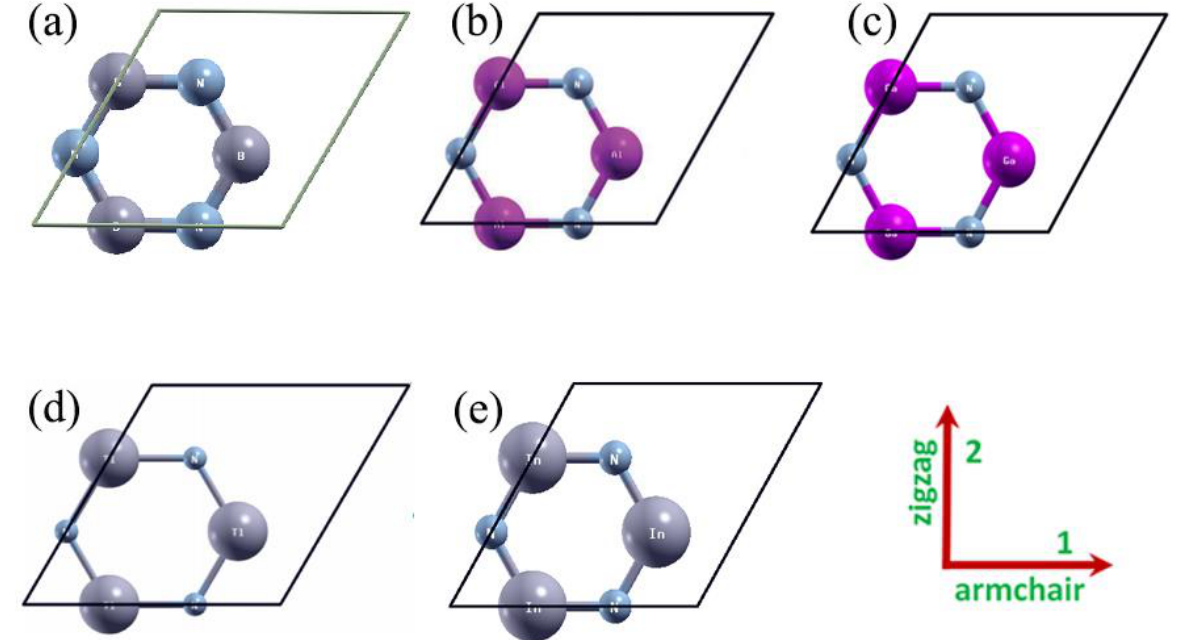
Figure 1. Atomic ( a ) super cell (24 atoms) of h-BN; ( b ) structure of g-AlN in the conventional unit cell (6 atoms); ( c ) structure of g -GaN in the conventional unit cell (6 atoms); ( d ) structure of g -TlN in the conventional unit cell (6 atoms); ( e ) structure of g -InN in the conventional unit cell (6 atoms) in the undeformed reference configuration.